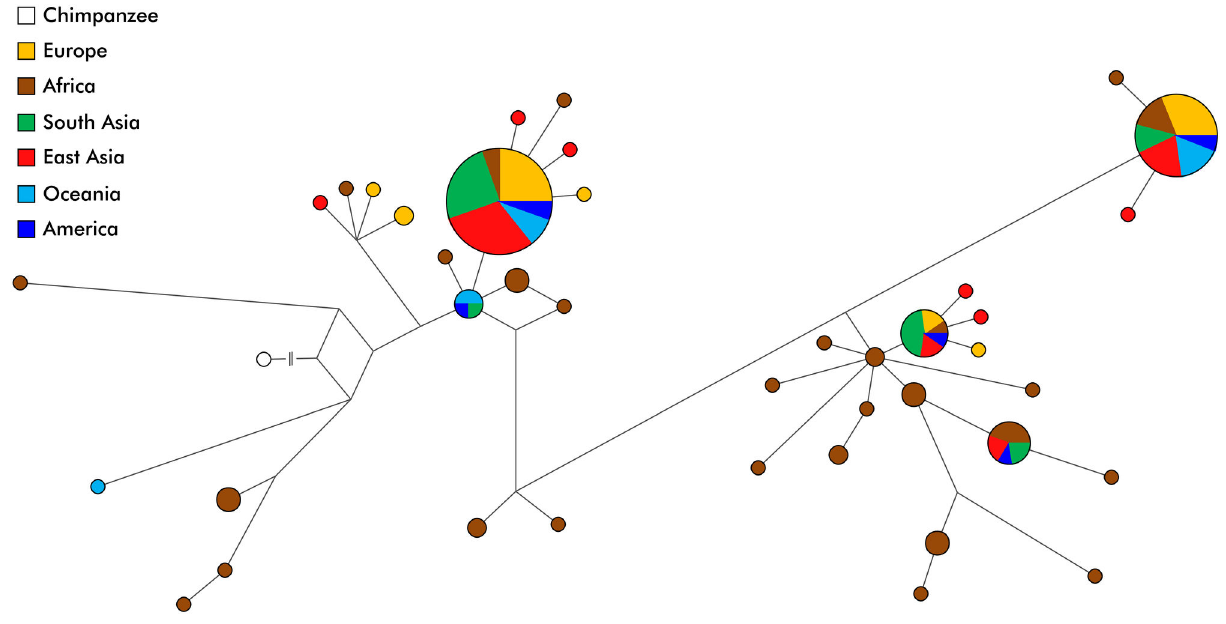
Figure 2. Median-joining network of TYR haplotypes. The network is based on the analysis of sequence data of the first haplotype block of 8634 bp length in 81 samples (162 chromosomes), color-coded by the geographic region of origin of the samples. Chimpanzee sequence (white circle) was used as an outgroup and chimpanzee specific variants have been excluded from the network